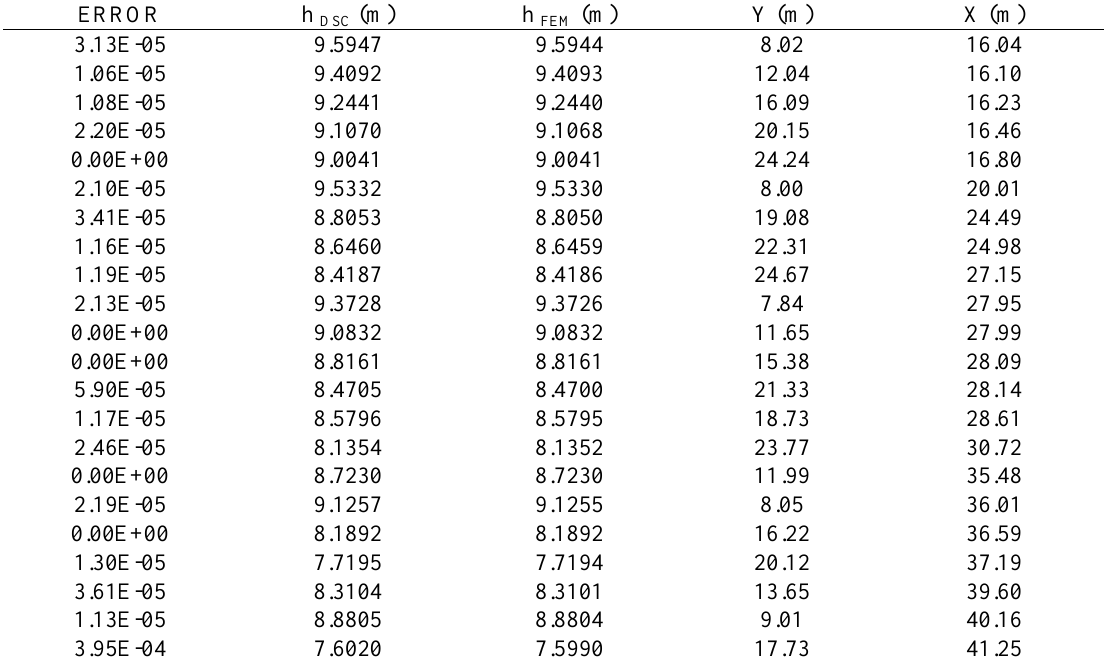
Table1 Comparison of the water heads obtained from the DSC and finite element methods at some nodes in (x, y) coordinate